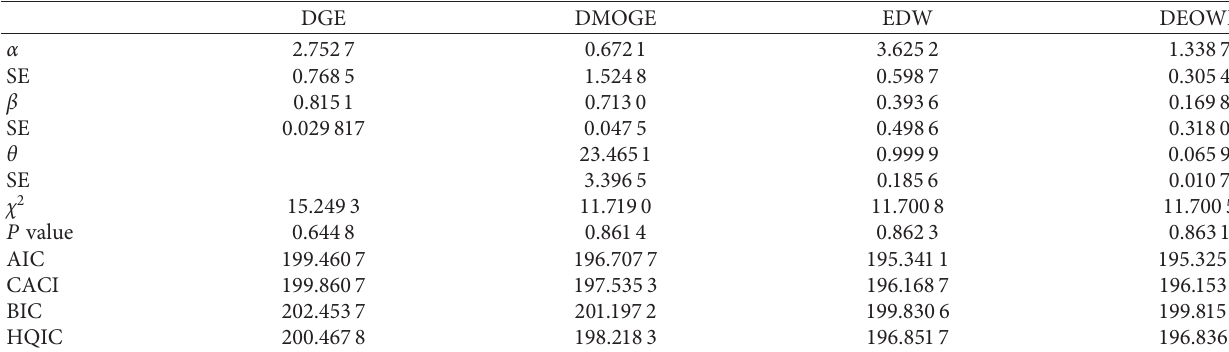
Table 11: MLE and SE for models’ parameters and goodness-of-fit criteria for each